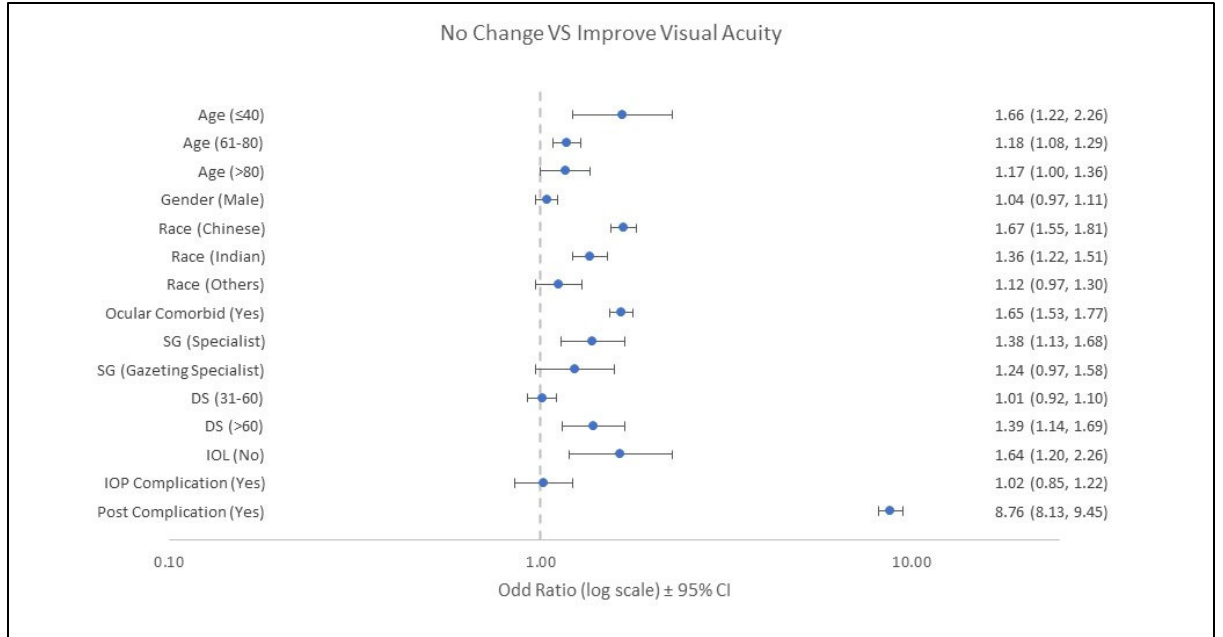
Figure 1. Forest plot of no change VA versus improved VA (ref). Reference for age was 41–60 years old, gender was female, race was Malay, ocular comorbid was no, surgeon grade (SG) was medical officer, duration of surgery (DS) was ≤ 30 min, intraocular lens (IOL) was yes, intraoperative complication (IOP) was no, and postoperative complication (Post) was